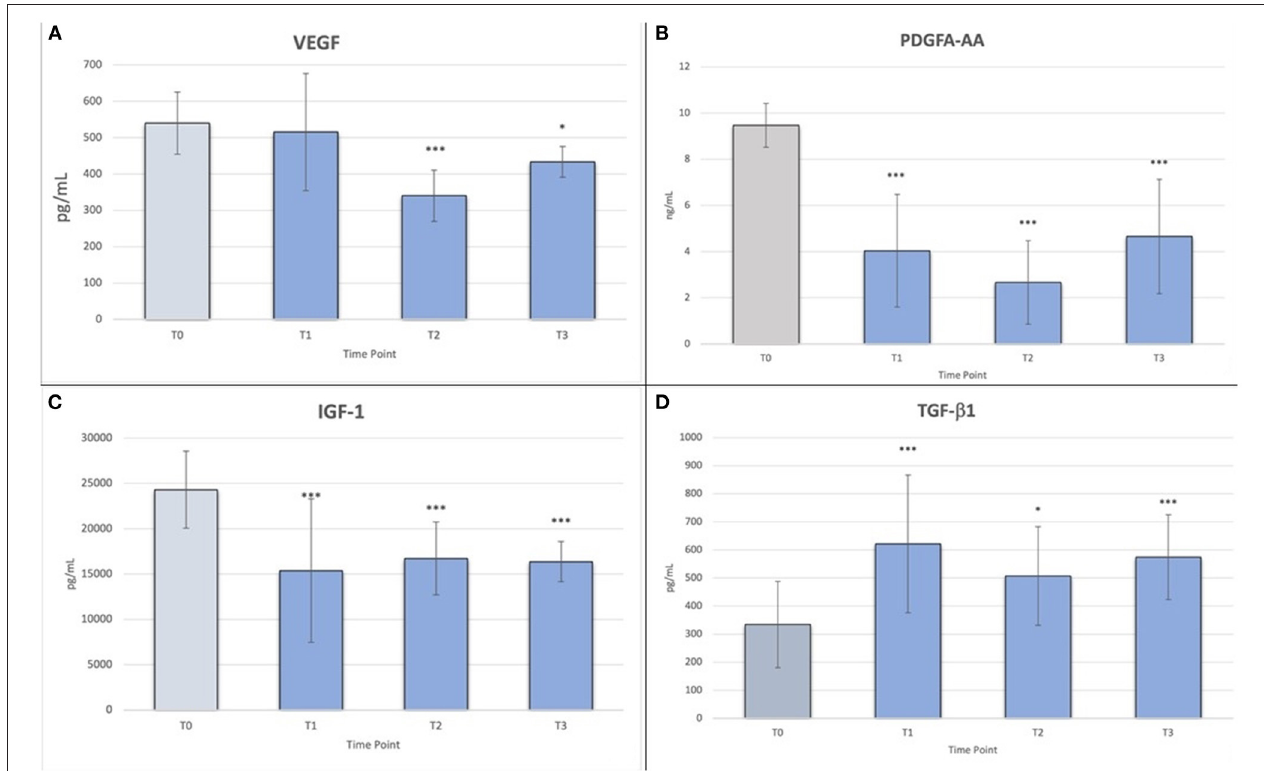
FIGURE 3 | (A) Friedman’s ANOVA test values for VEGF; * p < 0.05; *** p < 0.001; (B) Friedman’s ANOVA test values for PDGF-AA; *** p < 0.001; (C) Friedman’s ANOVA test values for IGF-1; *** p < 0.001; (D) Friedman’s ANOVA test values for TGF- β 1; * p < 0.05, *** p <